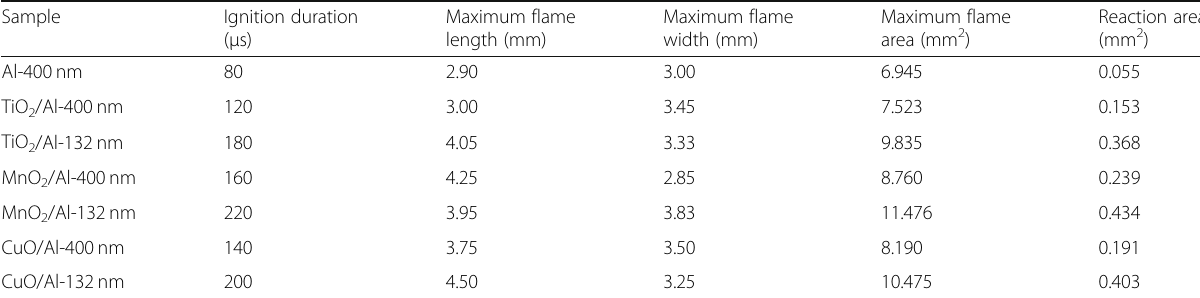
Table 1 Laser-induced properties of the single-layer Al film and various RMFs induced at 32.20 J/cm 2 Sample